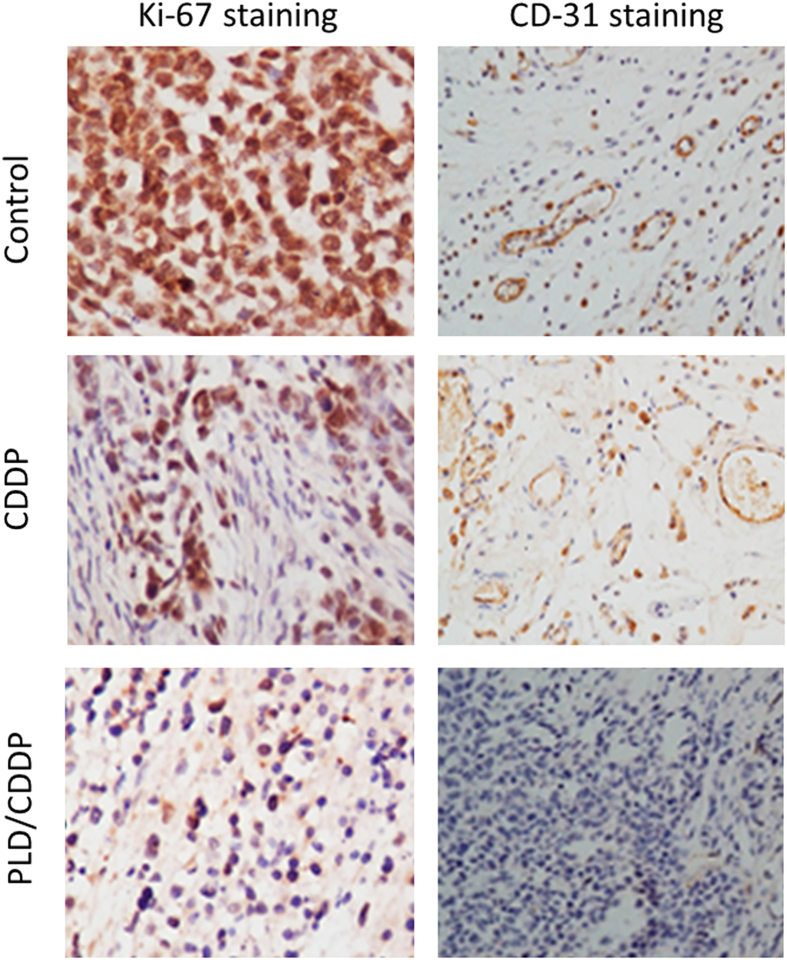
Immunohistochemistry studies performed in tumor samples.The expression level of CD31 and Ki67 apoptosis markers were investigated in extracted tumor samples.